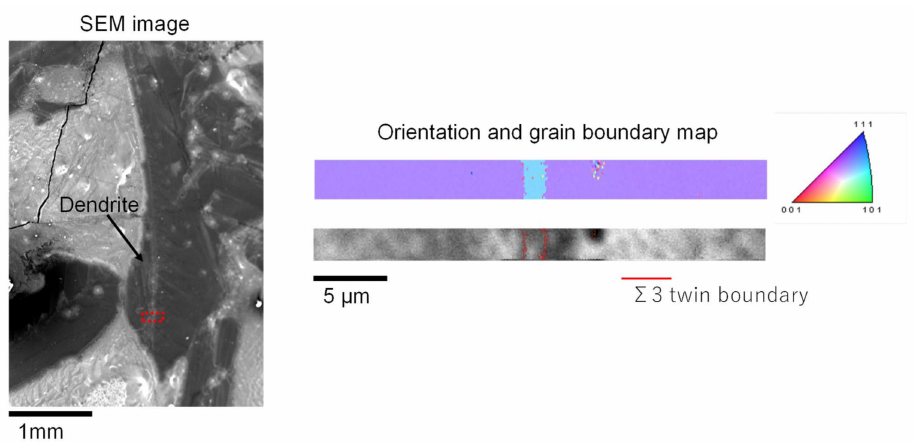
Figure 3. Structural analysis of dendrite observed in Si 0.7 Ge 0.3 melt by SEM-EBSP. The SEM image is shown at the left. The orientation map is shown at the upper right, and the grain boundary characteristics in the region of the dotted red box in the SEM image at the lower